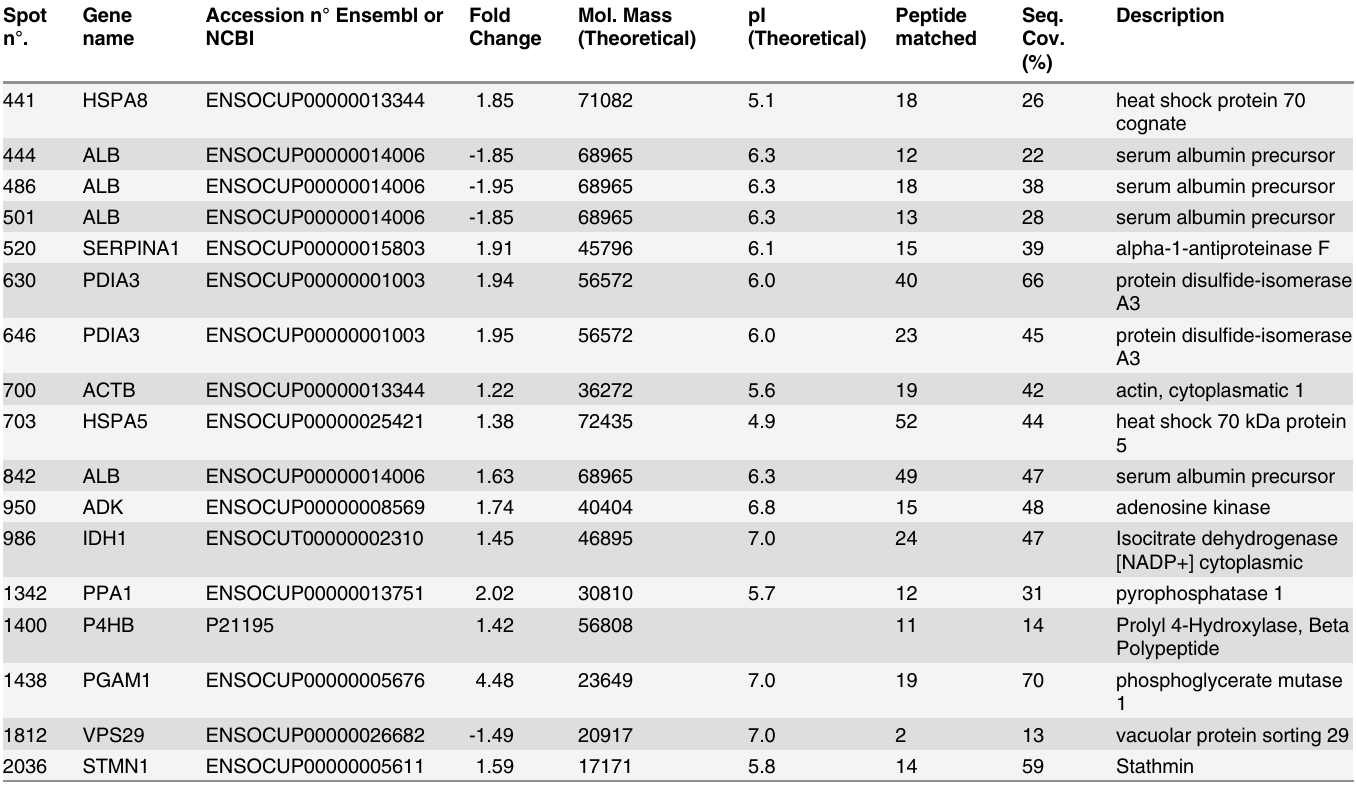
Table 3. List of identified altered proteins at Day 24 of gestation. Spot